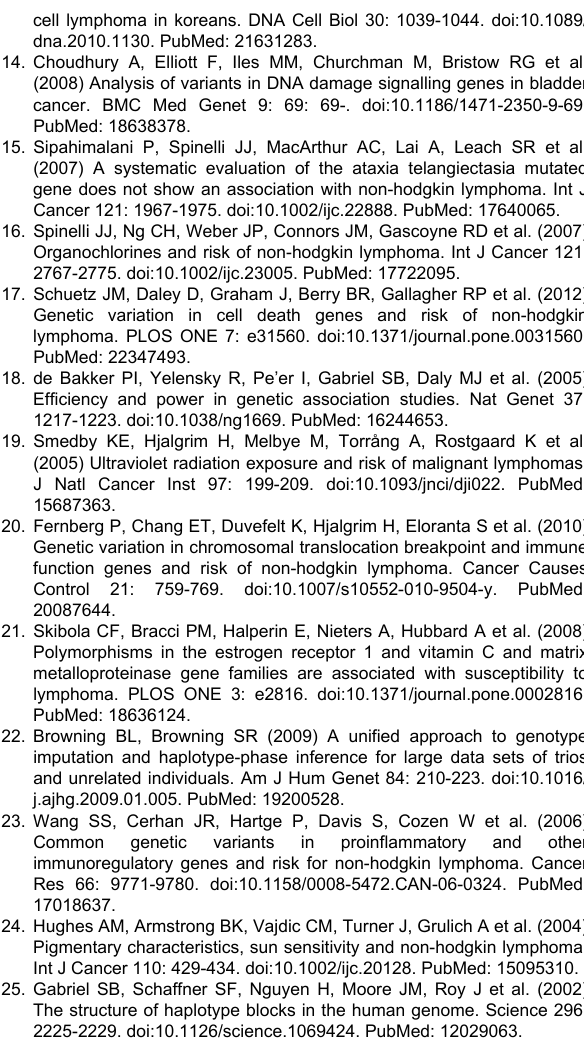
Table S3. Subtype-specific sex-SNP interaction analysis in the BC population.